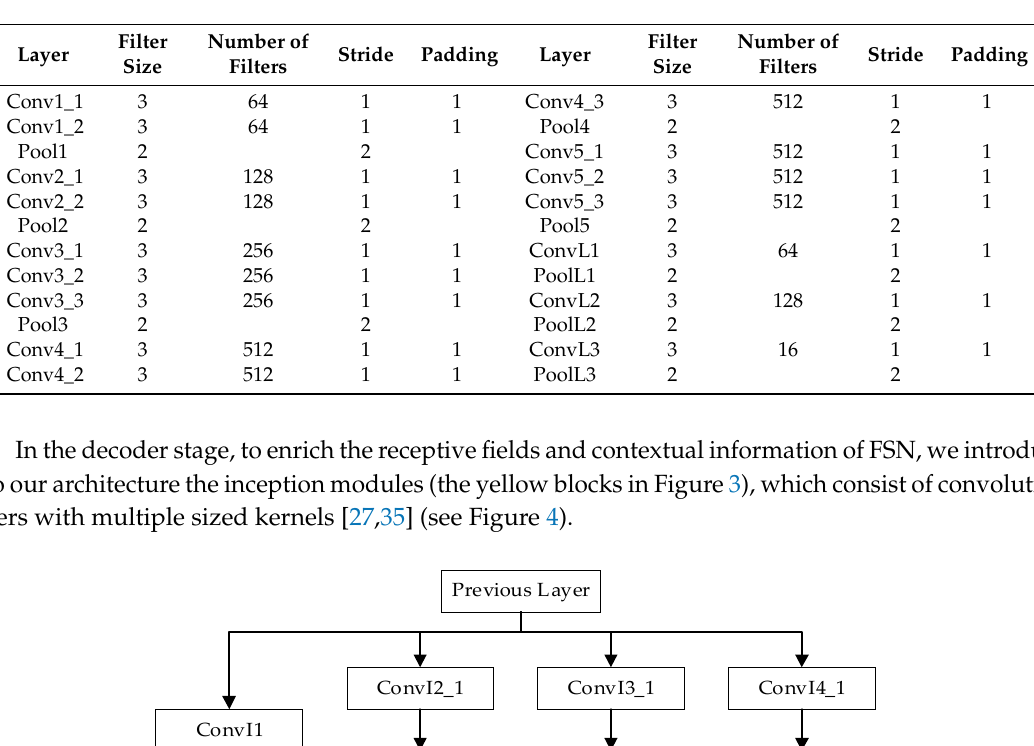
Table 1. Configurations of lightweight branch.